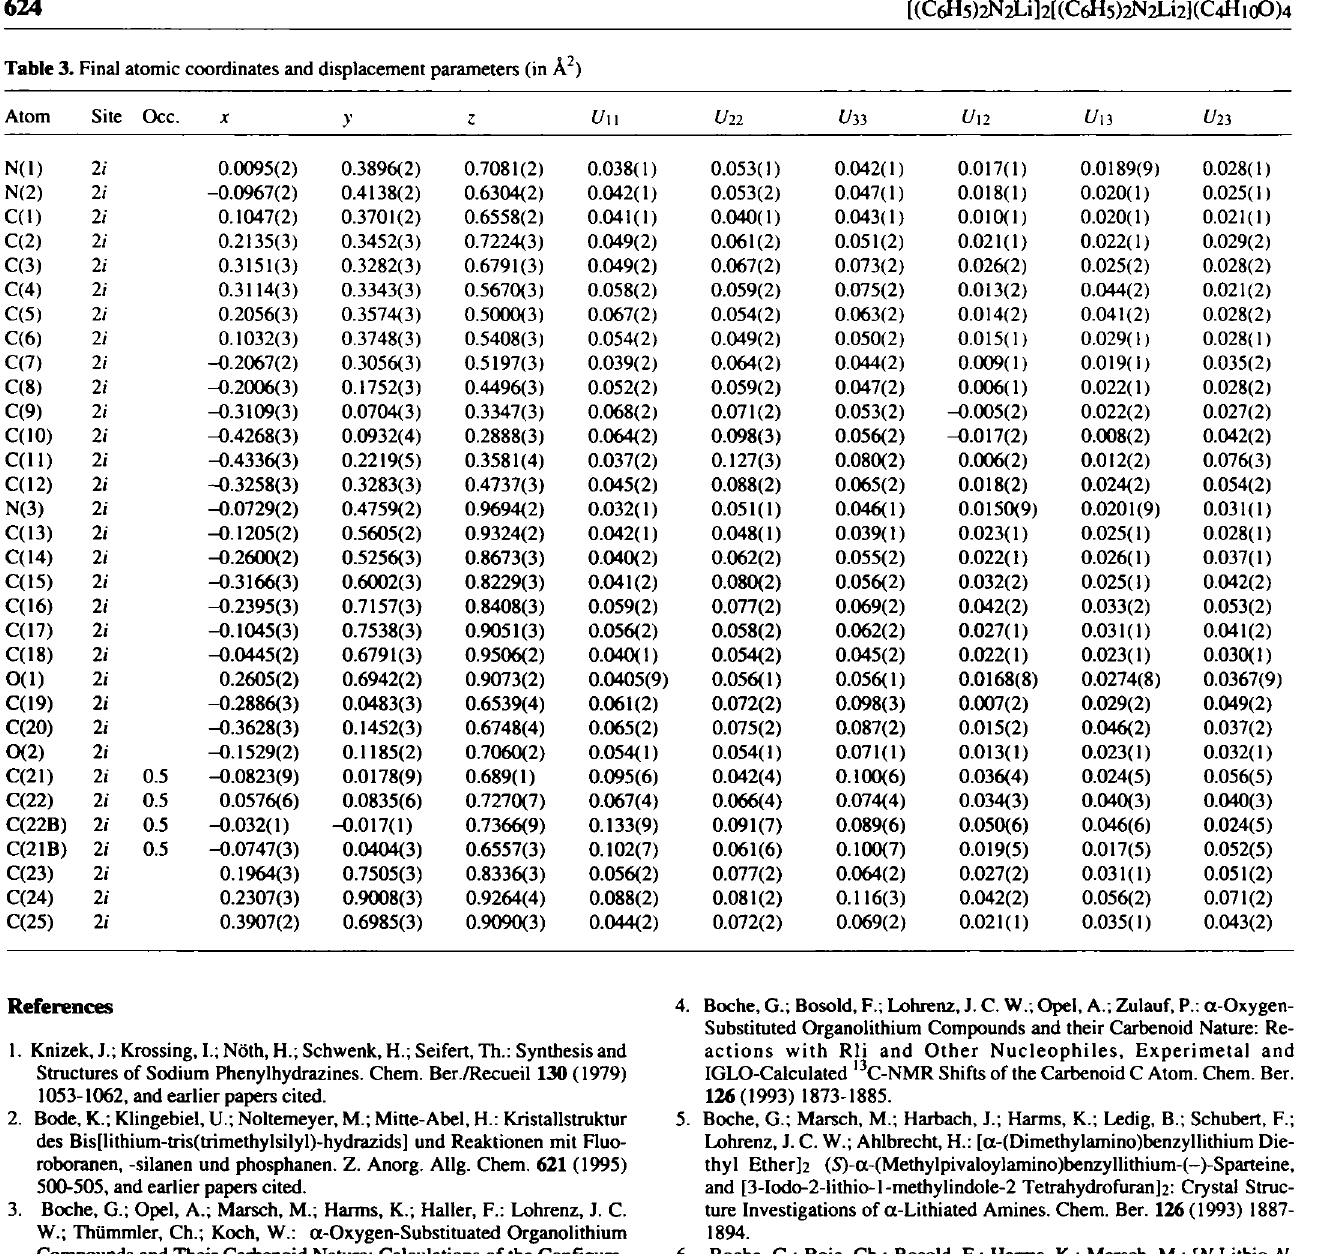
Table 3. Fina] atomic coordinates and displacement parameters (in Â^) Atom Site